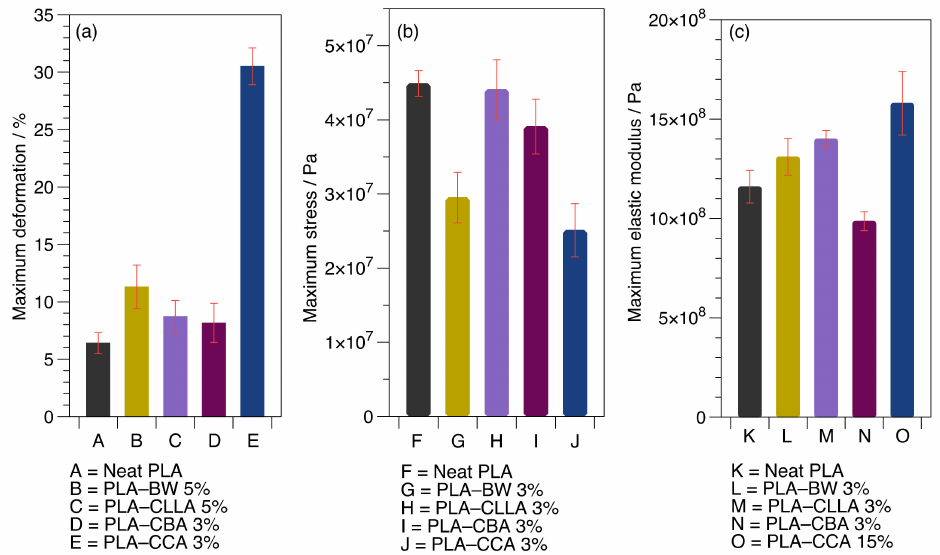
Figure 6. Maximum values were obtained in each set of blends. ( a ) Maximum deformation, ( b ) maxi- mum stress, and ( c ) maximum elastic